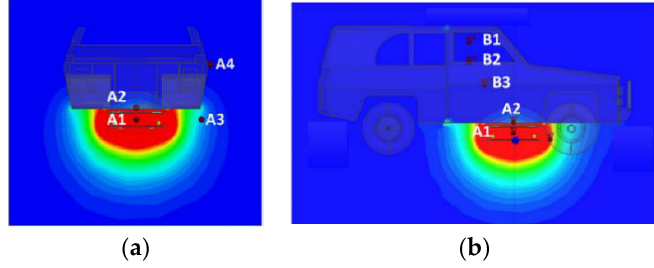
Figure 12. Magnetic field of aligned coils: ( a ) front view; ( b ) right view. Table 6. Position and magnetic field strength of test points.